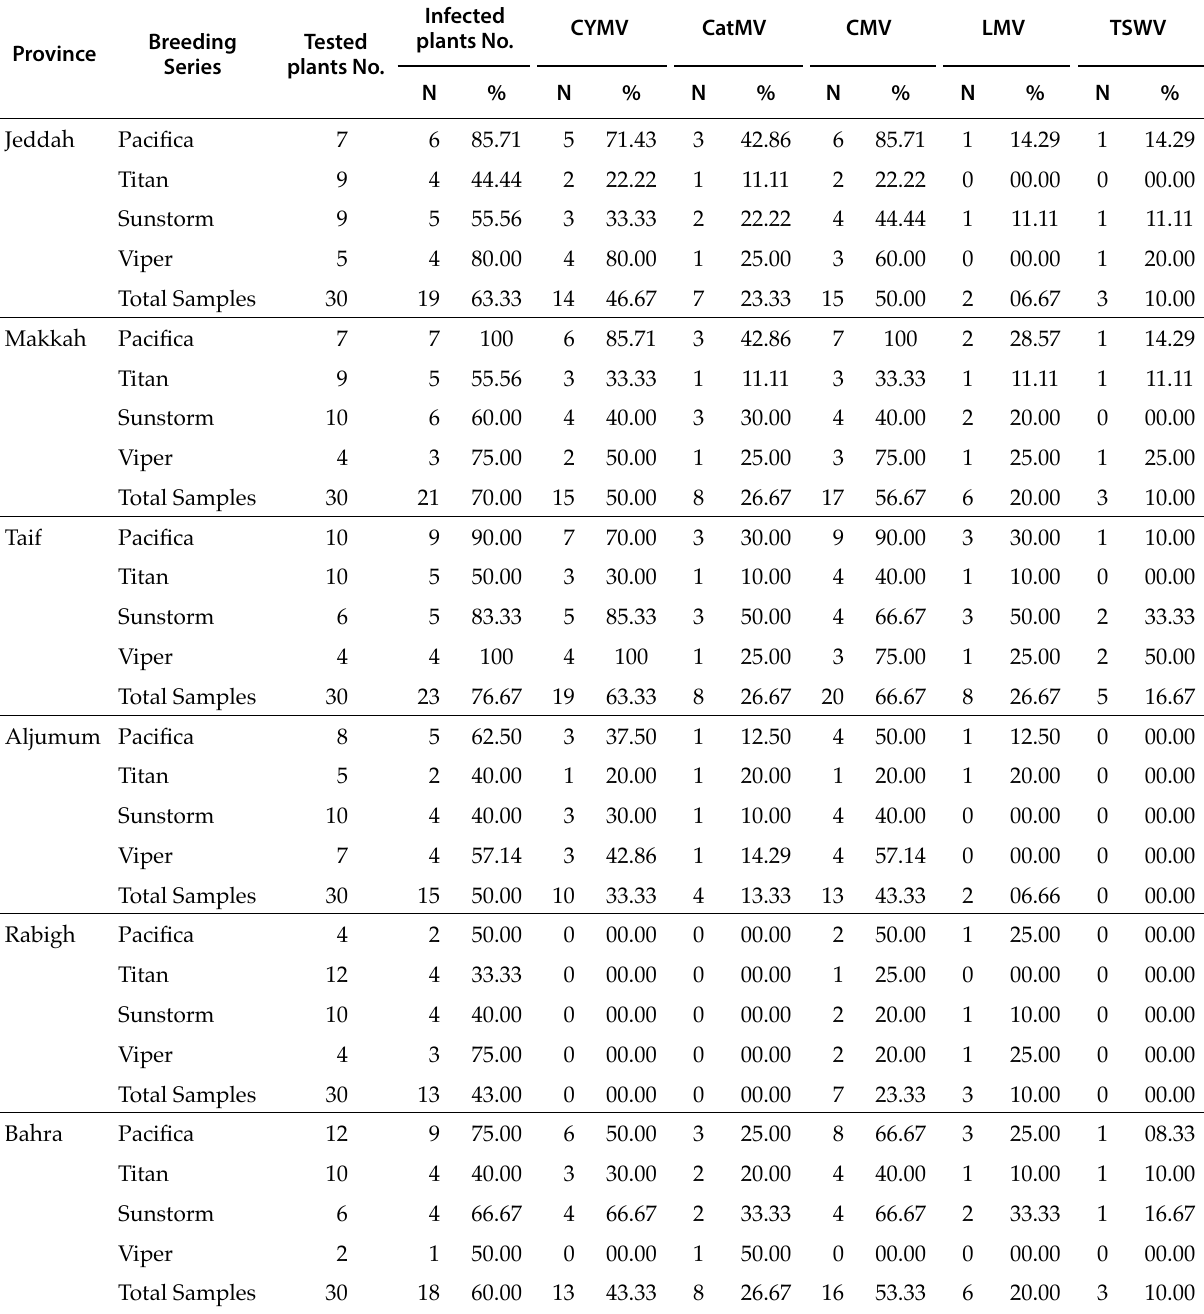
Table 2. Incidence of CYMV, CatMV, TSWV, CMV and LMV in tested samples, according to DAS-ELISA, PCR and RT-PCR assays conducted samples from 240 periwinkle plants of different breeding series, from eight Kingdom of Saudi Arabia